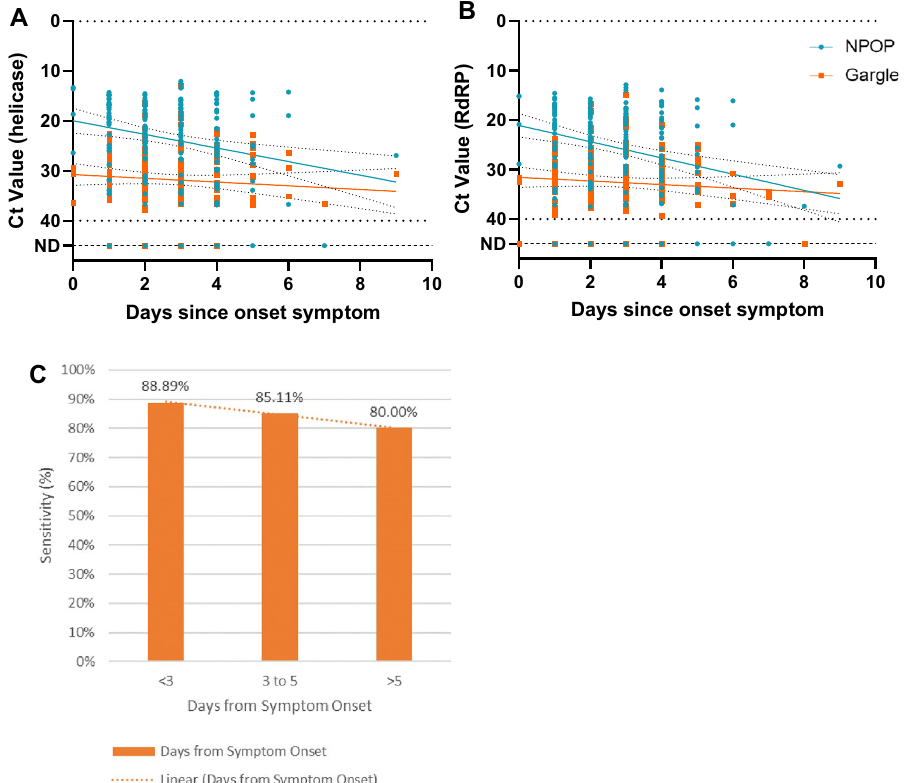
Figure 3. Ct values were lower in earlier periods of infection for both NPOP swab and gargle specimens, as evidenced by the trend in the virus target genes helicase ( A ) and RdRP ( B ). This resulted in a lower sensitivity (80%) on samples collected longer than 5 days since symptom onset ( C ).